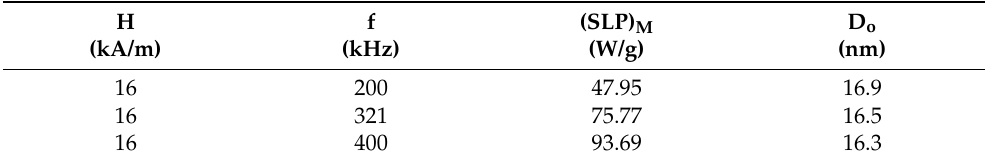
Table 3. The values of the maximum specific loss power (SLP) M and the nanoparticle diameter (D o ) corresponding to (SLP) M for three frequencies in the case of fixed nanoparticles.